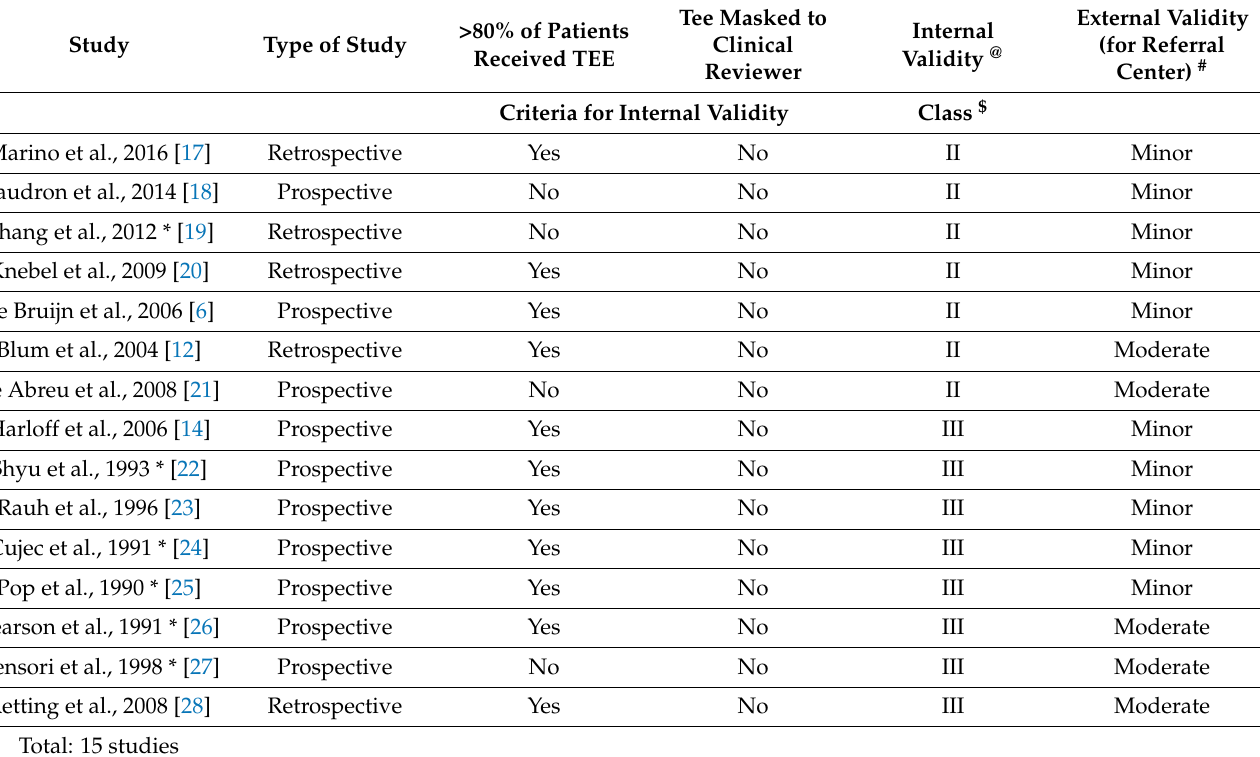
Table 1. Study characteristics and validity